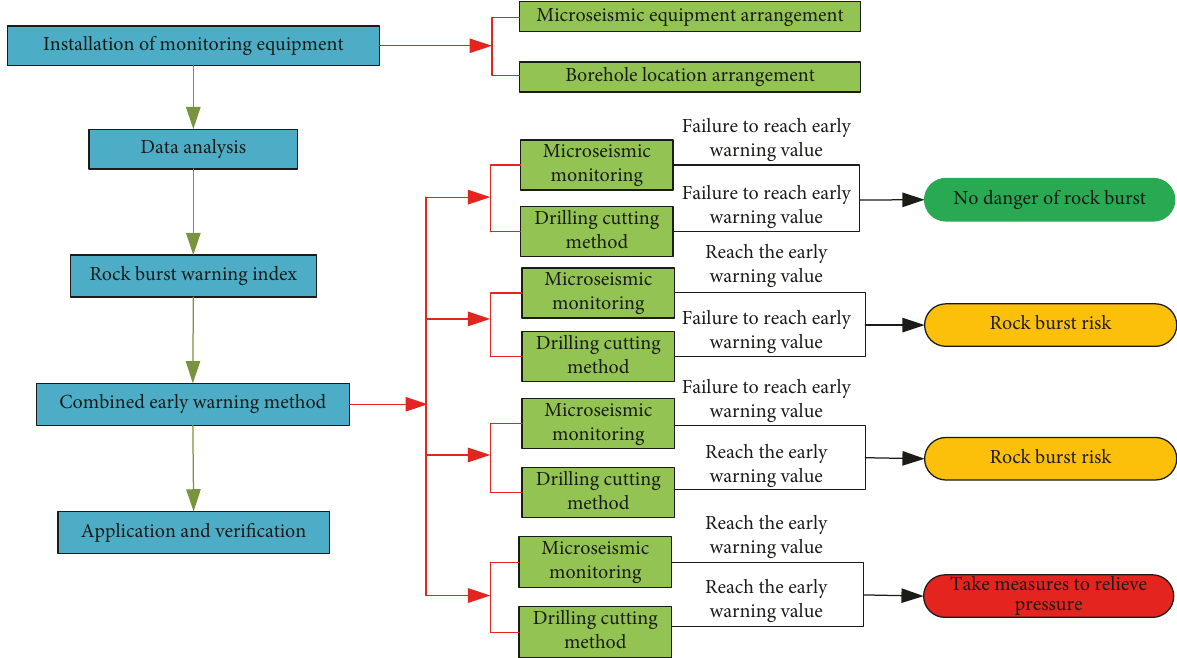
Figure 2: The flow chart of the combined early warning